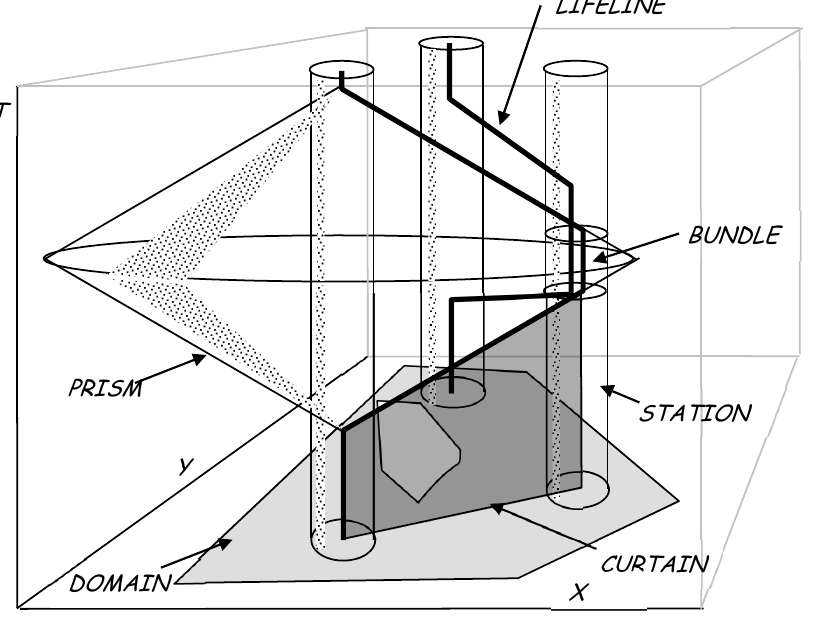
Figure 2 . The time geography aquarium, or space-time cube. Figure 2. The time geography aquarium, or space-time